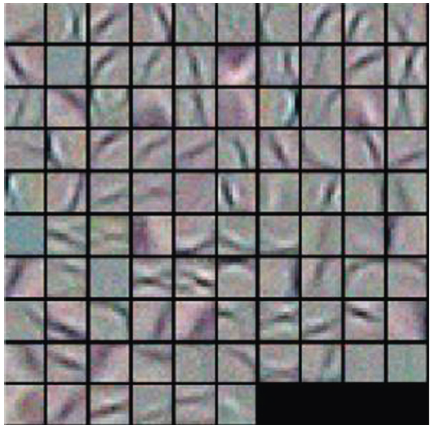
Figure 8: Visualized convolution kernels of